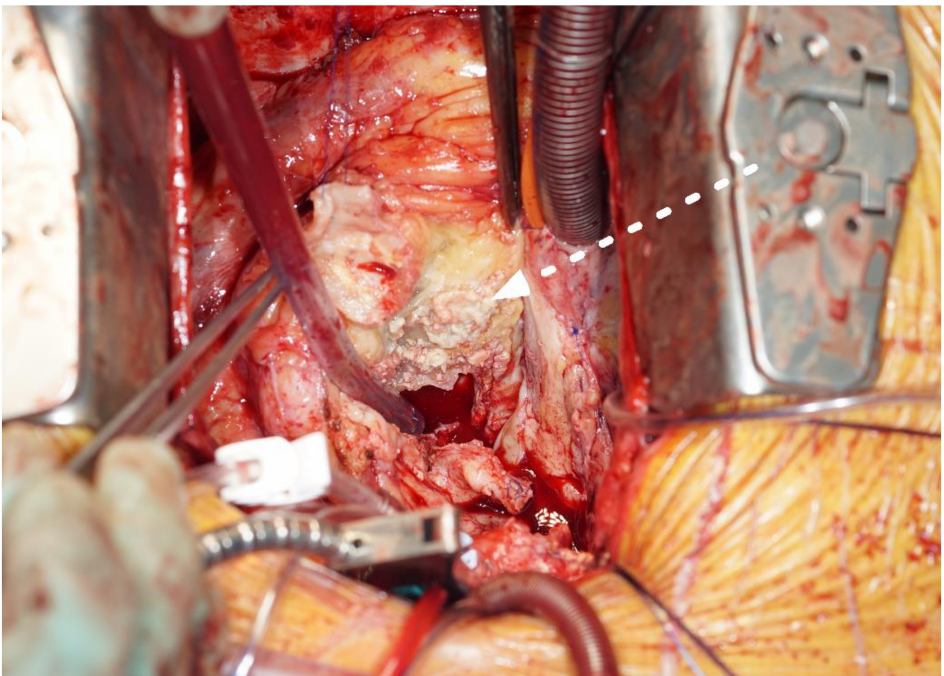
Figure 2. Aortic periannular abscess extending to the right atrial roof (white arrow, cranial view, Case n ◦ 6).